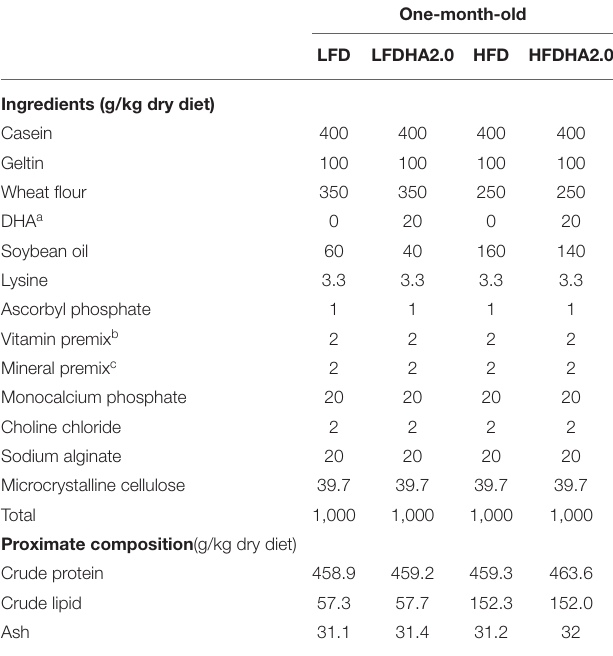
TABLE 1 | Ingredients of experimental diets for one-month-old zebrafish (g/kg). One-month-old LFD LFDHA2.0 HFD